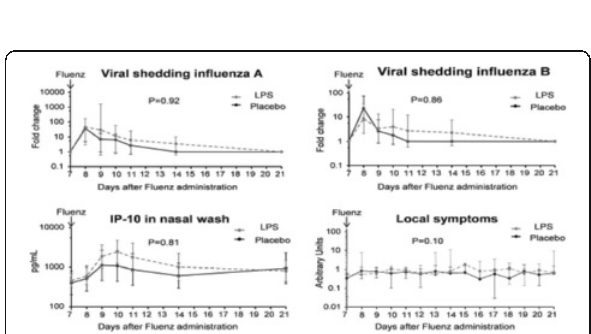
Fig. 53 (abstract A137). Viral shedding in nasal wash of the influenza A and B strain (upper panels), levels of IP-10 in nasal wash (lower left panel) and local symptoms (lower right panel) following intranasal administration of Fluenz in subjects that were administered LPS or placebo one week before. Data are presented as Geometric means with 95 % CI. P-values are calculated on area under curves using Man Whitney U